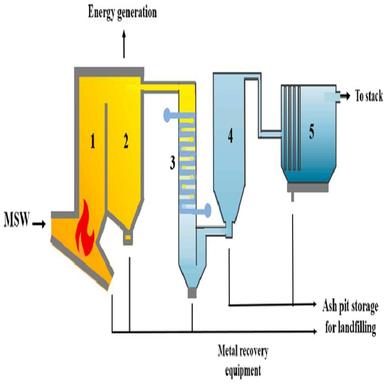
The process of MSW slagging-gasification (a) and conventional MSW incineration (b).